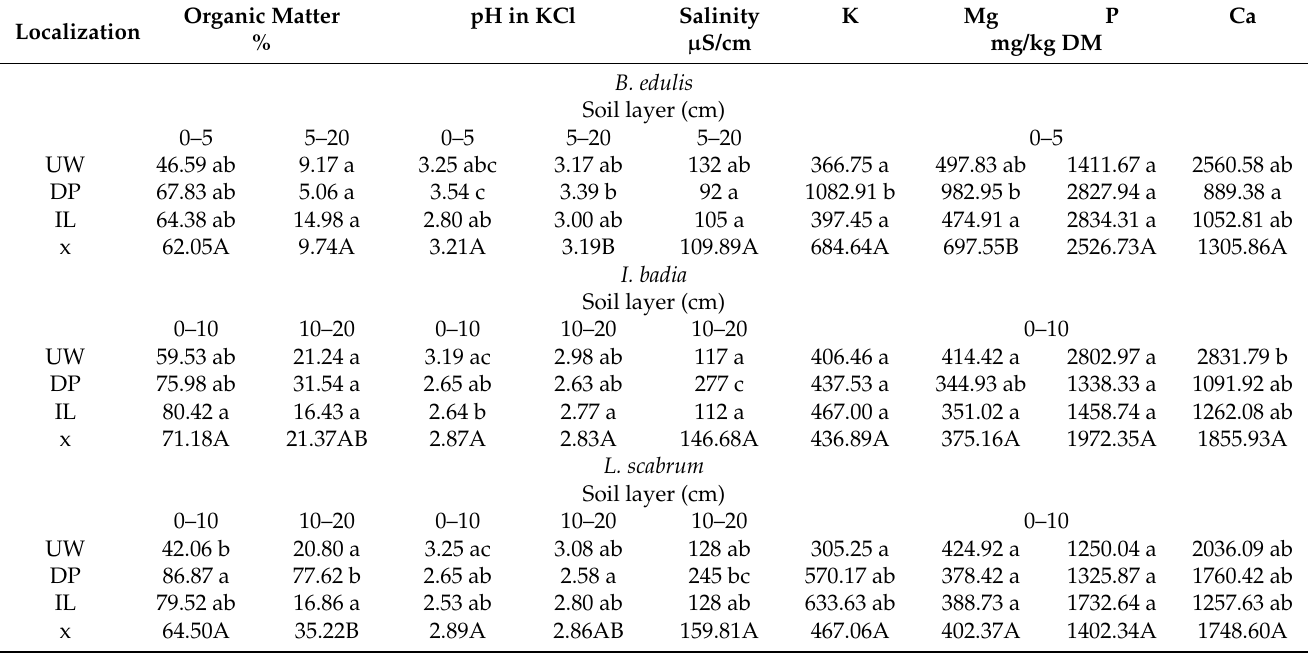
Table 1. Contents of organic matter and available forms of macronutrients, pH and salinity in soils.